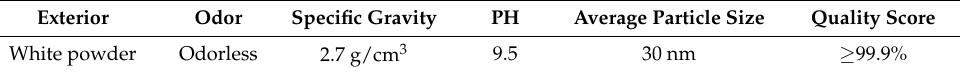
Table 3. Basic properties of CAH.